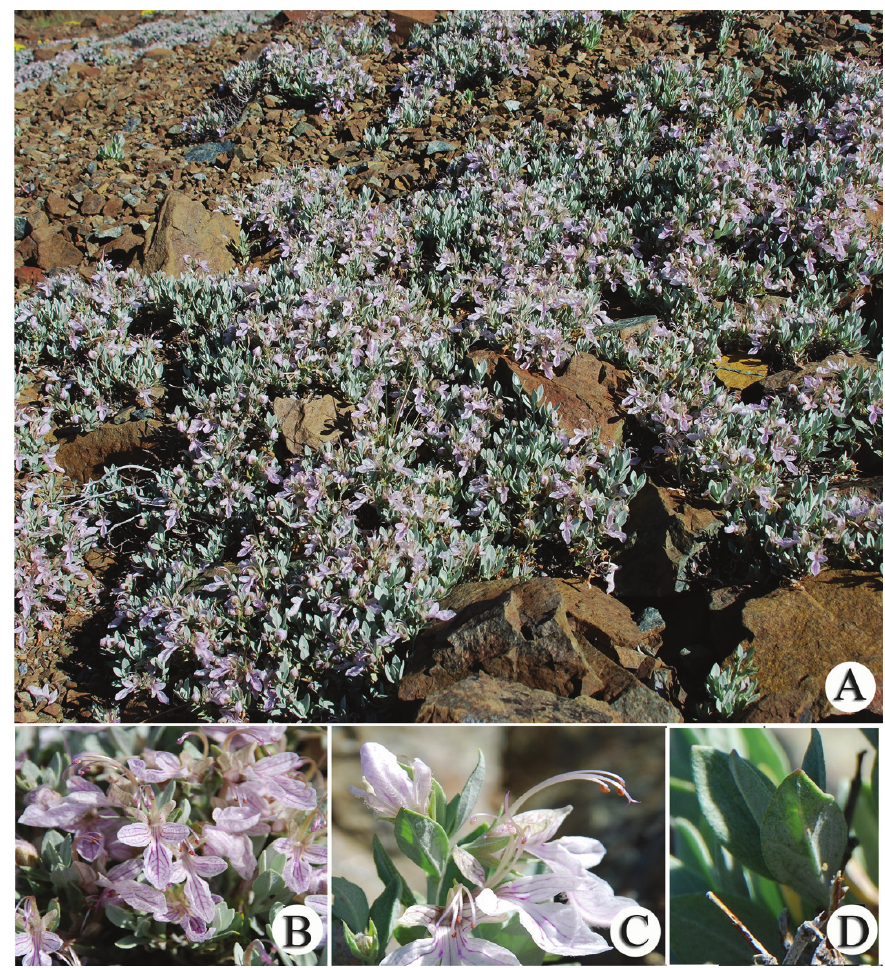
Figure 1. T. alyssifolium. A habitus B inflorescence C flower D leaf. lower-density trichomes than the lower epidermis. The spherocrystals occur in the upper epidermis cells of the leaf in T. allysifolium . Leaves are isolateral. The mesophyll is differentiated into 1 layered palisade and 2–3-layered spongy parenchyma. The pali- sade parenchyma cells are under the upper and lower